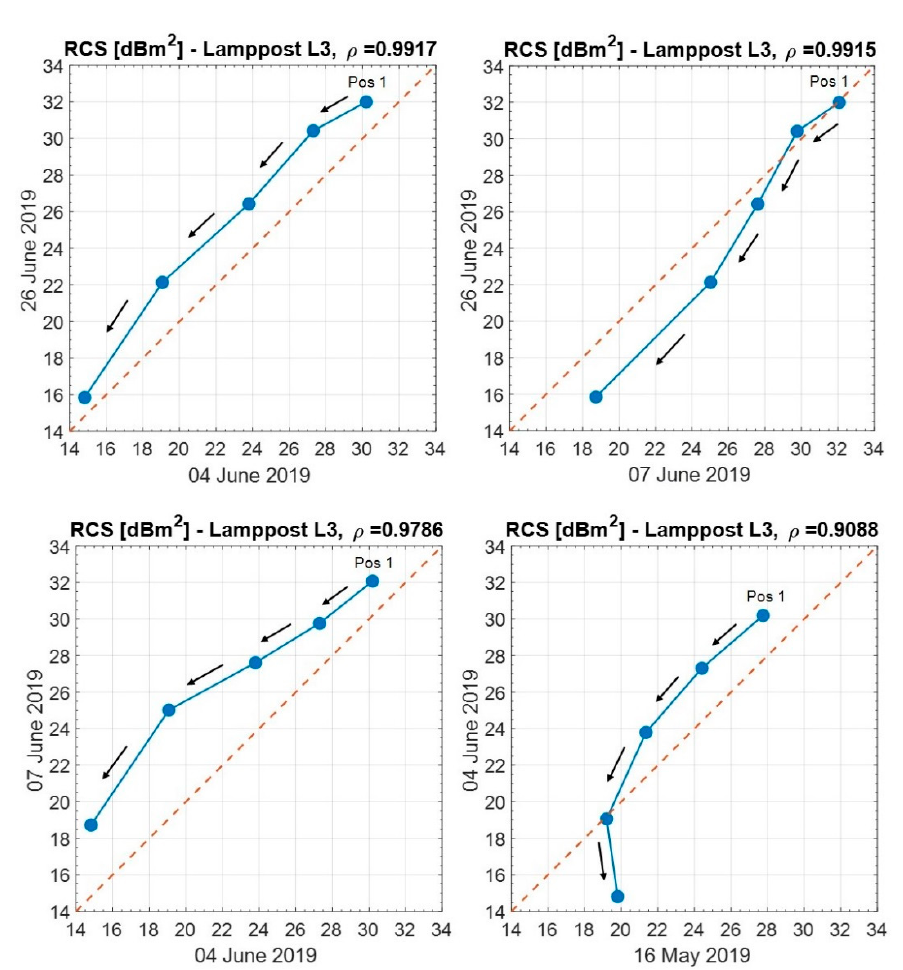
Figure 14. Comparison of the measured RCS of lamppost L3 on different days, varying the antenna position. Starting from the maximum antenna elevation (Position 1), the arrows denote the successive positions of the antenna up to the minimum elevation.